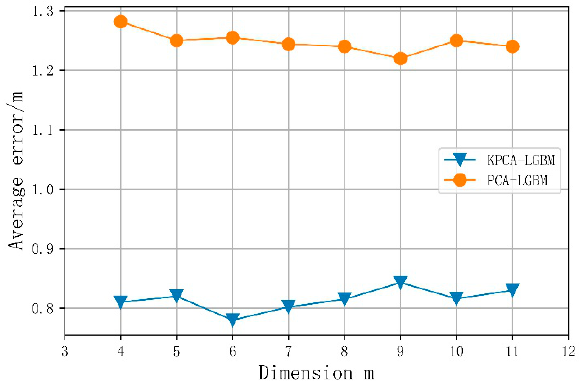
Figure 6. Influence of fingerprint dimension on average positioning error.